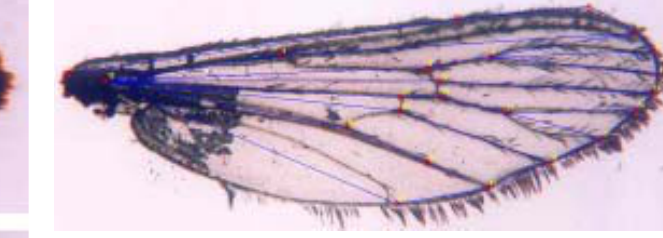
A Figure 2. Plots of Culex quinquefasciatus used in the present study superimposed on the reference configuration using affine generalized resistant fit analysis. The reference configuration is shown with lines.